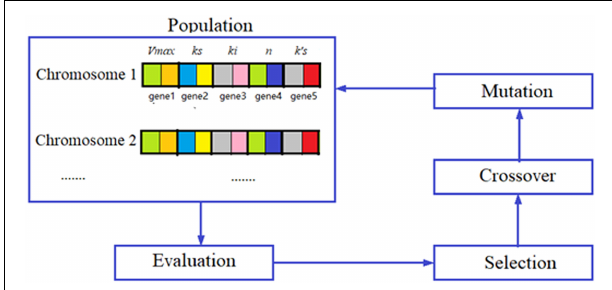
FIGURE 8 | Diagram of the genetic algorithm in parameter value optimization.